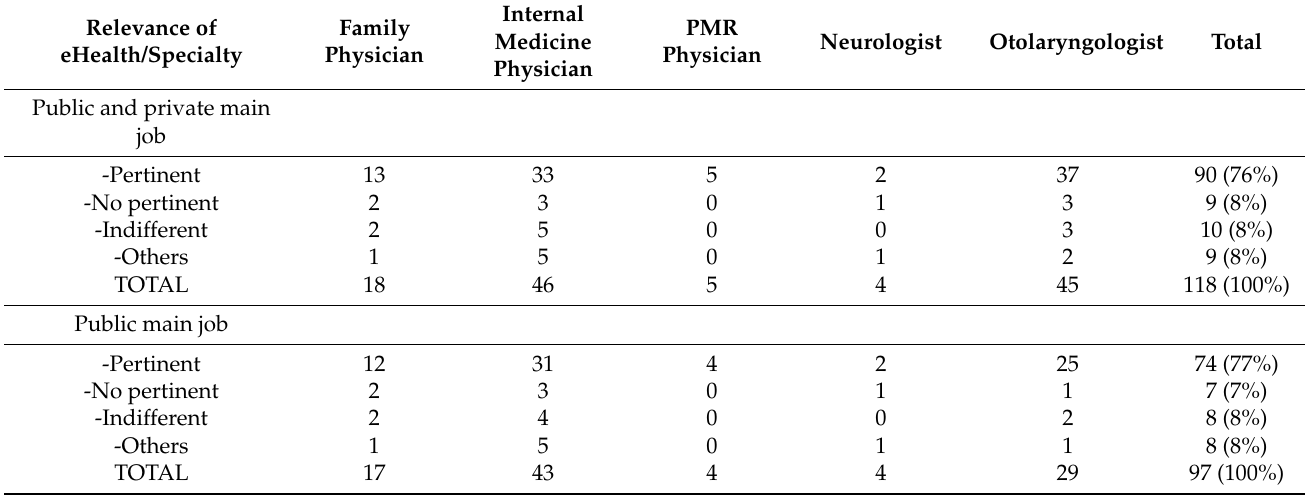
Table 3. Questionnaire: Relevance degree about the use of eHealth in the context of care provision for the elderly with balance disorders and the risk of